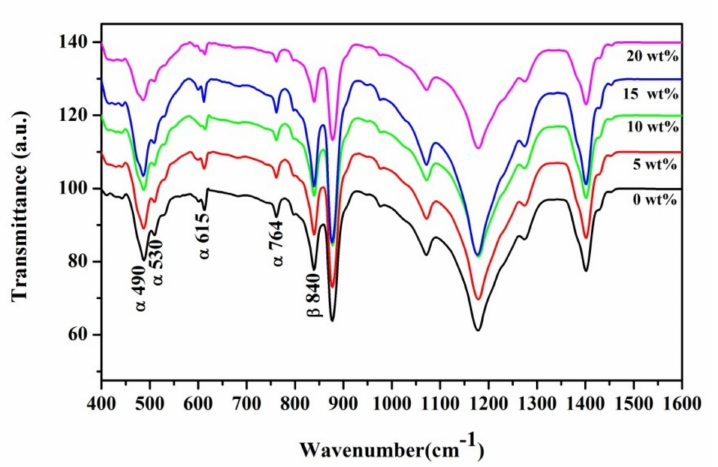
Figure 7. Infrared measurements for the P(VDF-HFP) and P(VDF-HFP)/ZnO electrospun membranes with different concentrations of ZnO (0, 5, 10,15, and 20 wt%),